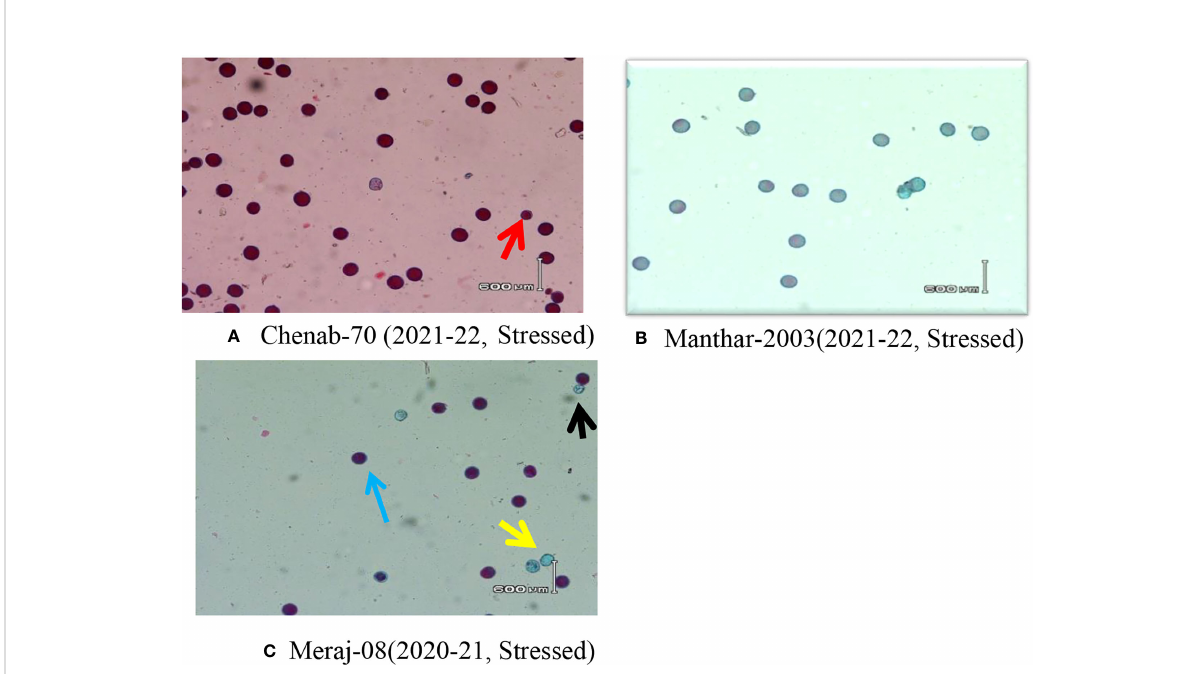
FIGURE 2 Microphotographs (10×) of wheat lines under stressed conditions during 2020 – 2021 and 2021 – 2022. (A) Smaller size of viable pollen (red arrow) under stress conditions. (B) All sterile/non-viable pollens under stress. (C) Meraj-08 stained with Alexander ’ s stain; the black arrow indicates non-viable pollen grains with a smaller size, the blue arrow indicates viable pollen grains, and the yellow arrow indicates non-viable pollen grains under stress